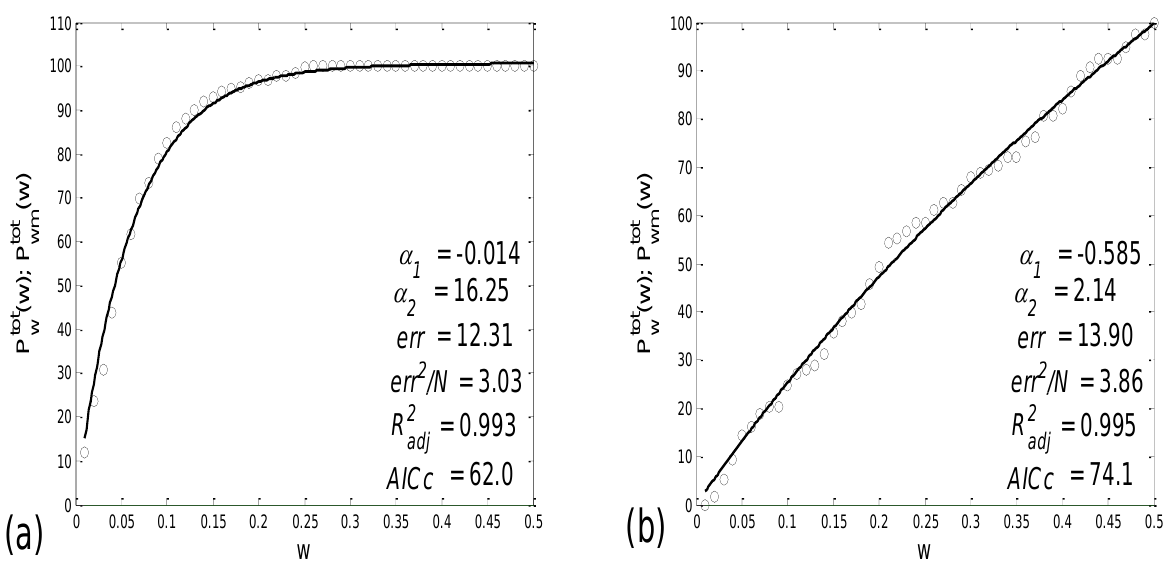
Figure 5. Examples of fitting the experimentally derived points P wtot ( w ) (open circles) with the model P wmtot ( w ) using Equation (9) (solid line). Four estimates for the quality of fitting are also given: error of fitting ( err ), square error per point ( err 2 / N ), R-square adjusted ( R 2 adj ), and Akaike’s information criterion ( AICc ). ( a ) An example showing pronounced aggregation, where P wtot ( w ) > P r ; ( b ) another example close to a random distribution of points, where P wtot ( w ) ≈ P r .